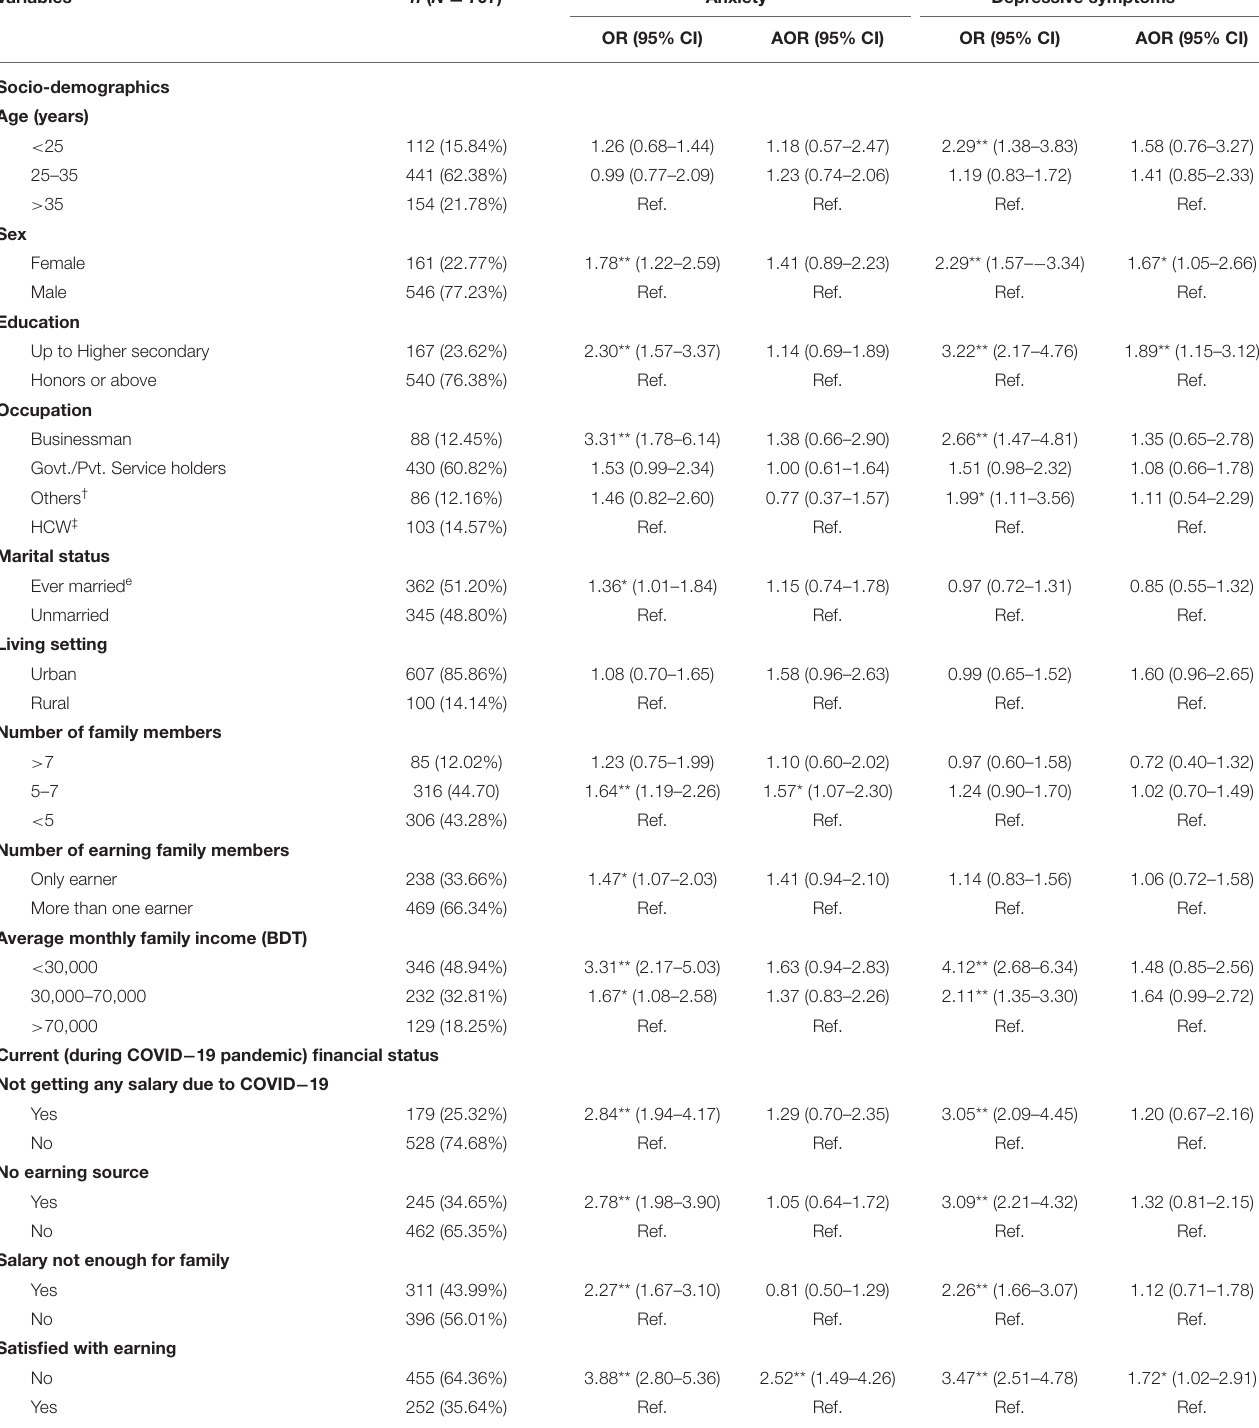
TABLE 4 | Adjustment of Odds-ratios (ORs) using all independent study variables.